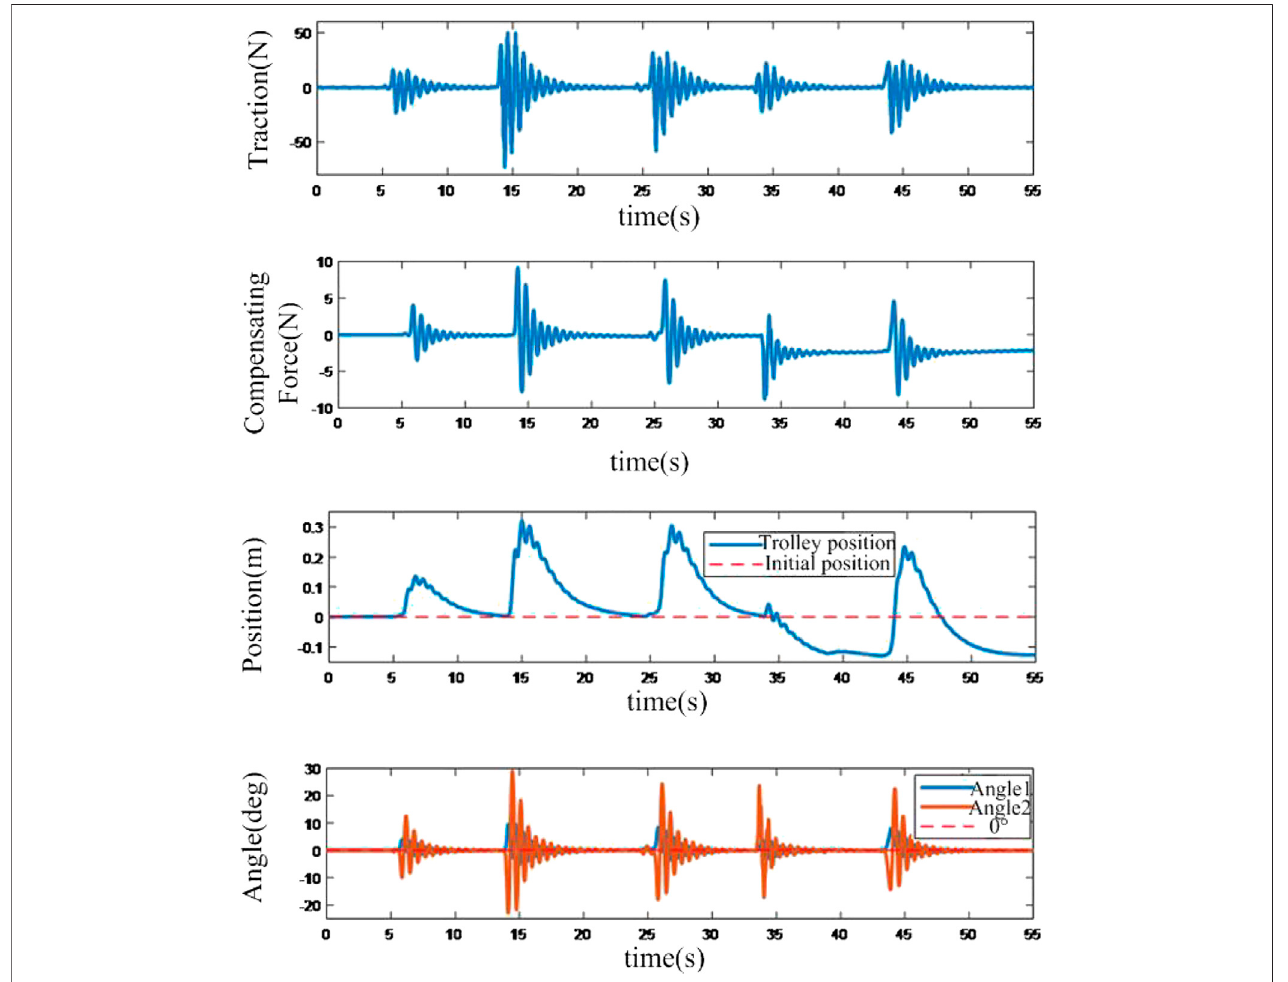
FIGURE 10 | Response of anti-disturbance system based on neural network based compensation controller.